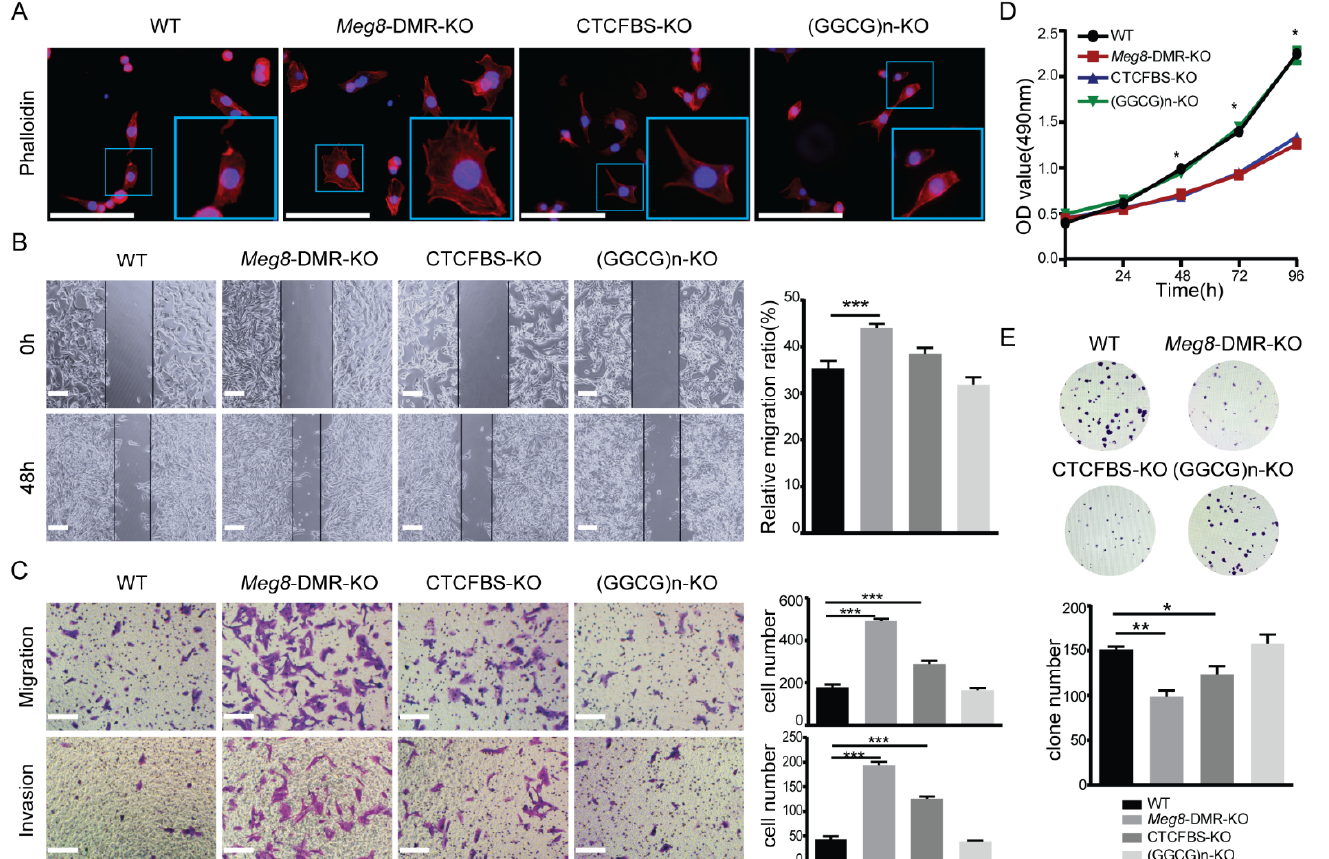
Figure 5. Meg8 -DMR deletion enhanced migration and invasion of MLTC-1. ( A ) Immunofluorescence staining of Phalloidin-California Red Conjugate in WT, Meg8 -DMR-KO, CTCFBS-KO, and (GGCG)n-KO. ( B ) Confluent monolayers of four cell lines were wounded and after being incubated for an additional 48 h, the relative migration ratio was calculated. ( C ) Migration and invasion of four cell lines were measured via Transwell assay. ( D ) Cell proliferation of four cell lines was measured via MTT assay. ( E ) Colonies grown from cells of four cell lines were counted. Error bars, mean ± SEM. n ≥ 3. p values were calculated using t -test. * p < 0.05, ** p < 0.01, *** p < 0.001, scale bars = 200 µ